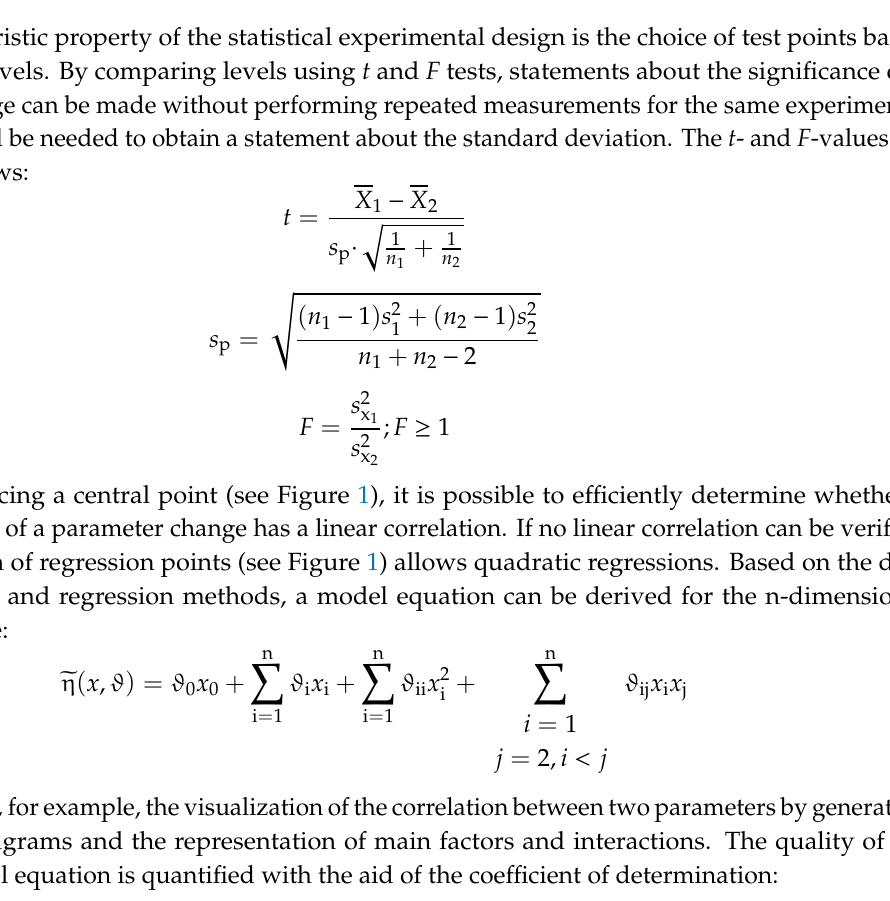
Figure 1. Schematic representation of the applied design plans for a 3-dimensional central composite design (CCC, three continuously variable input parameters) with α = √ 2.